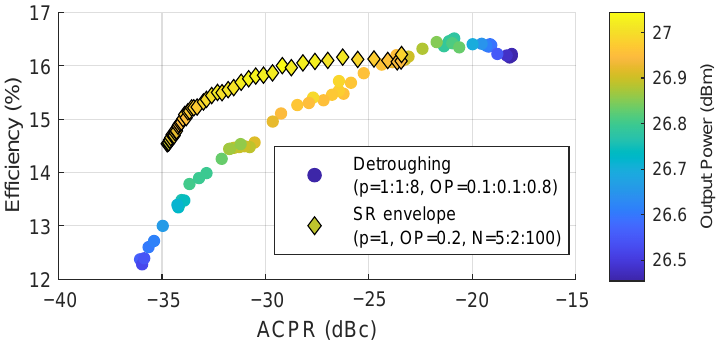
Figure 4. ACPR and efficiency trade-off and comparison between the detroughed envelope and the SR envelope.